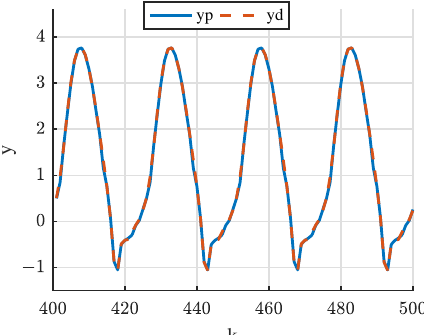
Figure 3. The predicted output with the desired output in 4.1.